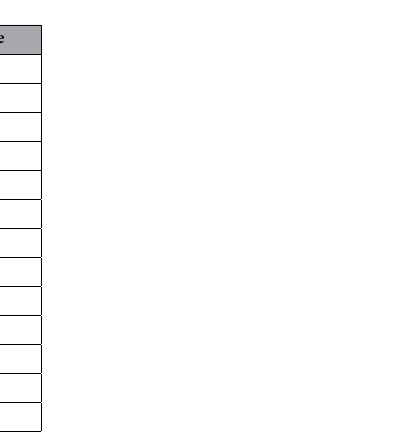
Table 1. Identification of proteins induced by selenite ( >